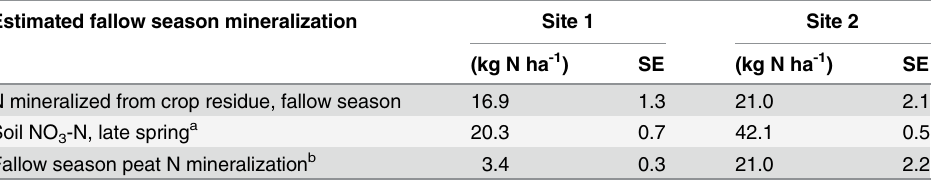
Table 5. Estimates of winter fallow season N mineralization and losses. Estimated fallow season mineralization